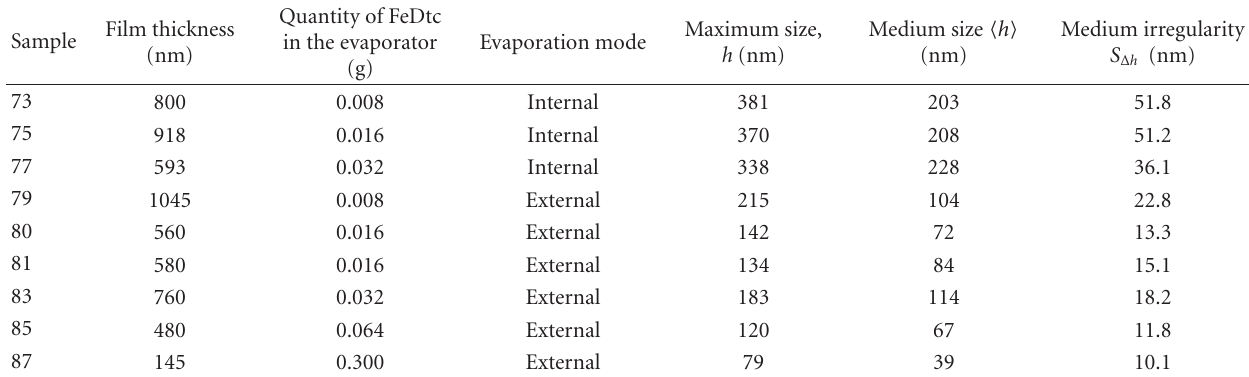
Figure 6: The AFM image of the sample with the thin film thickness ∼ 500 nm (the field size is 1.2 μ m by 1.2 μ m; the shades of grey corres- pond to the vertical scale of the recording of 0 to 250nm). External evaporator. Table 5: Surface morphology data of the samples TiO 2 :Fe obtained by